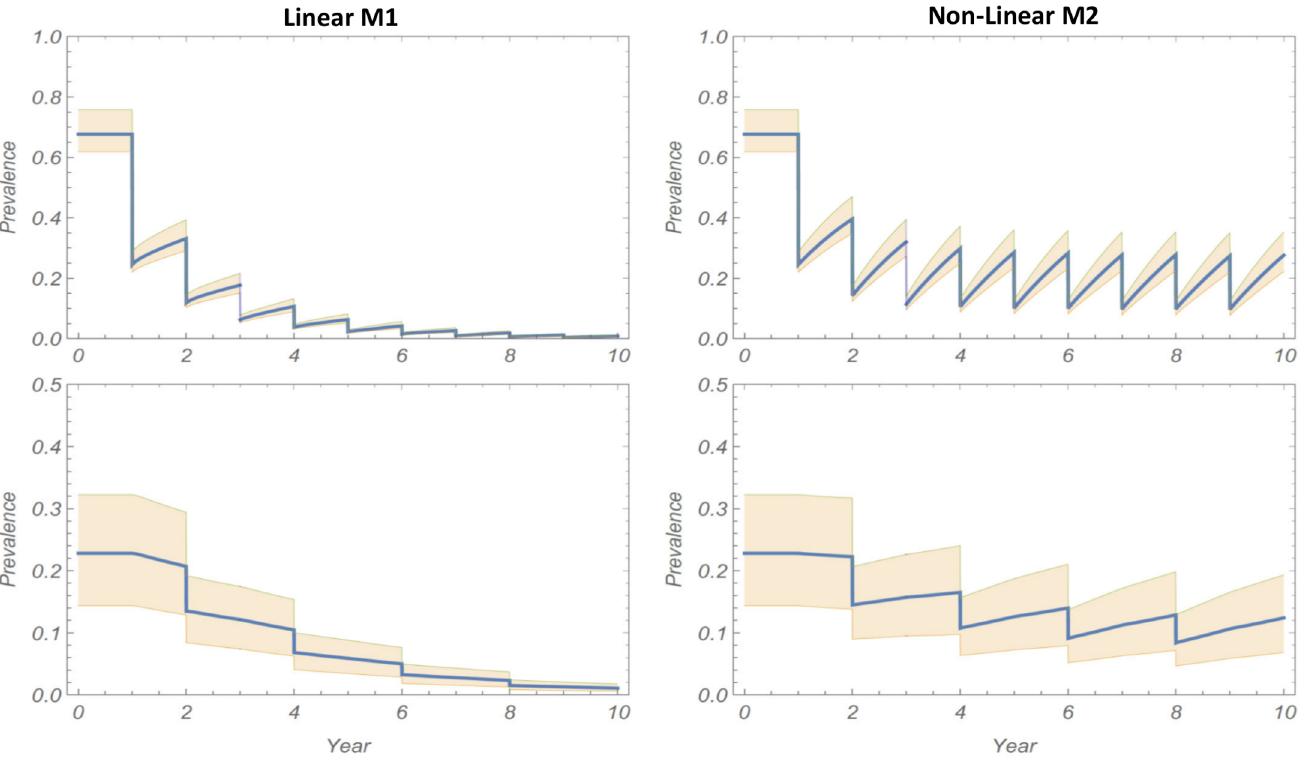
Fig 3. Sensitivity analysis of MDA regimen for the modeled community of Fig 2. Ensemble of 10-year histories over 20 random samples of the M1 and M2 models’ posterior parameter distributions. Left and right columns show respective results (mean history + 95% CI) for the linear M1 model and the nonlinear M2 model types of snail FOI inputs. In each column, the upper and lower graphs display the child and adult prevalence functions, respectively, over time.